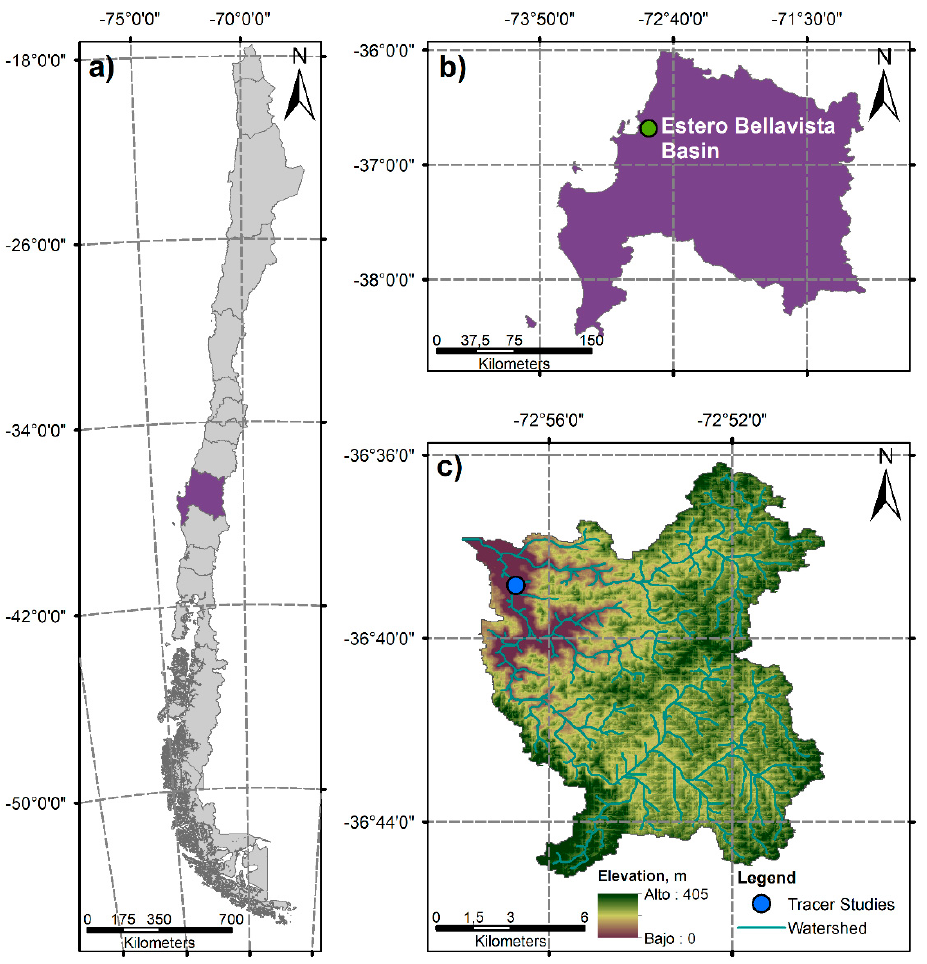
Figure 4. ( a ) Location of the Biobío region in Chile; ( b ) the Bellavista watershed location within the Biobío region; and ( c ) the tracer study location within the Bellavista watershed. Table 4. Geometric and flow characteristics for each study reach.